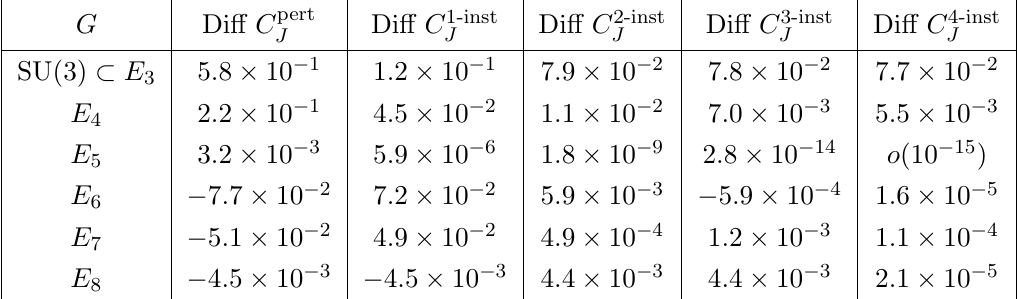
computed using J